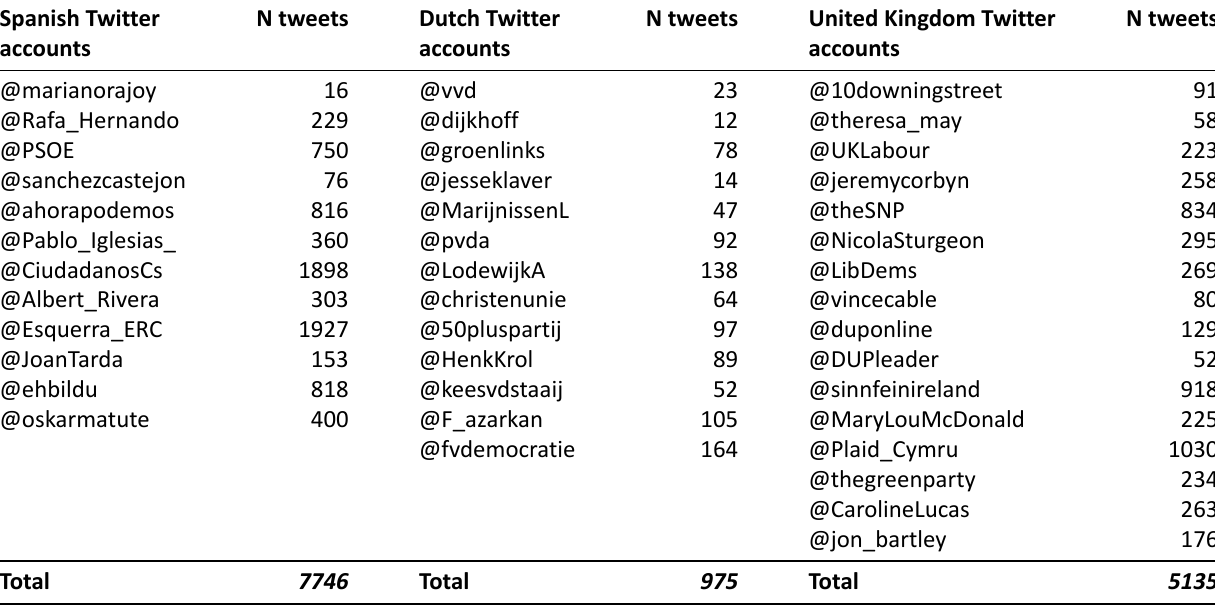
Table 2. Accounts analyzed, per